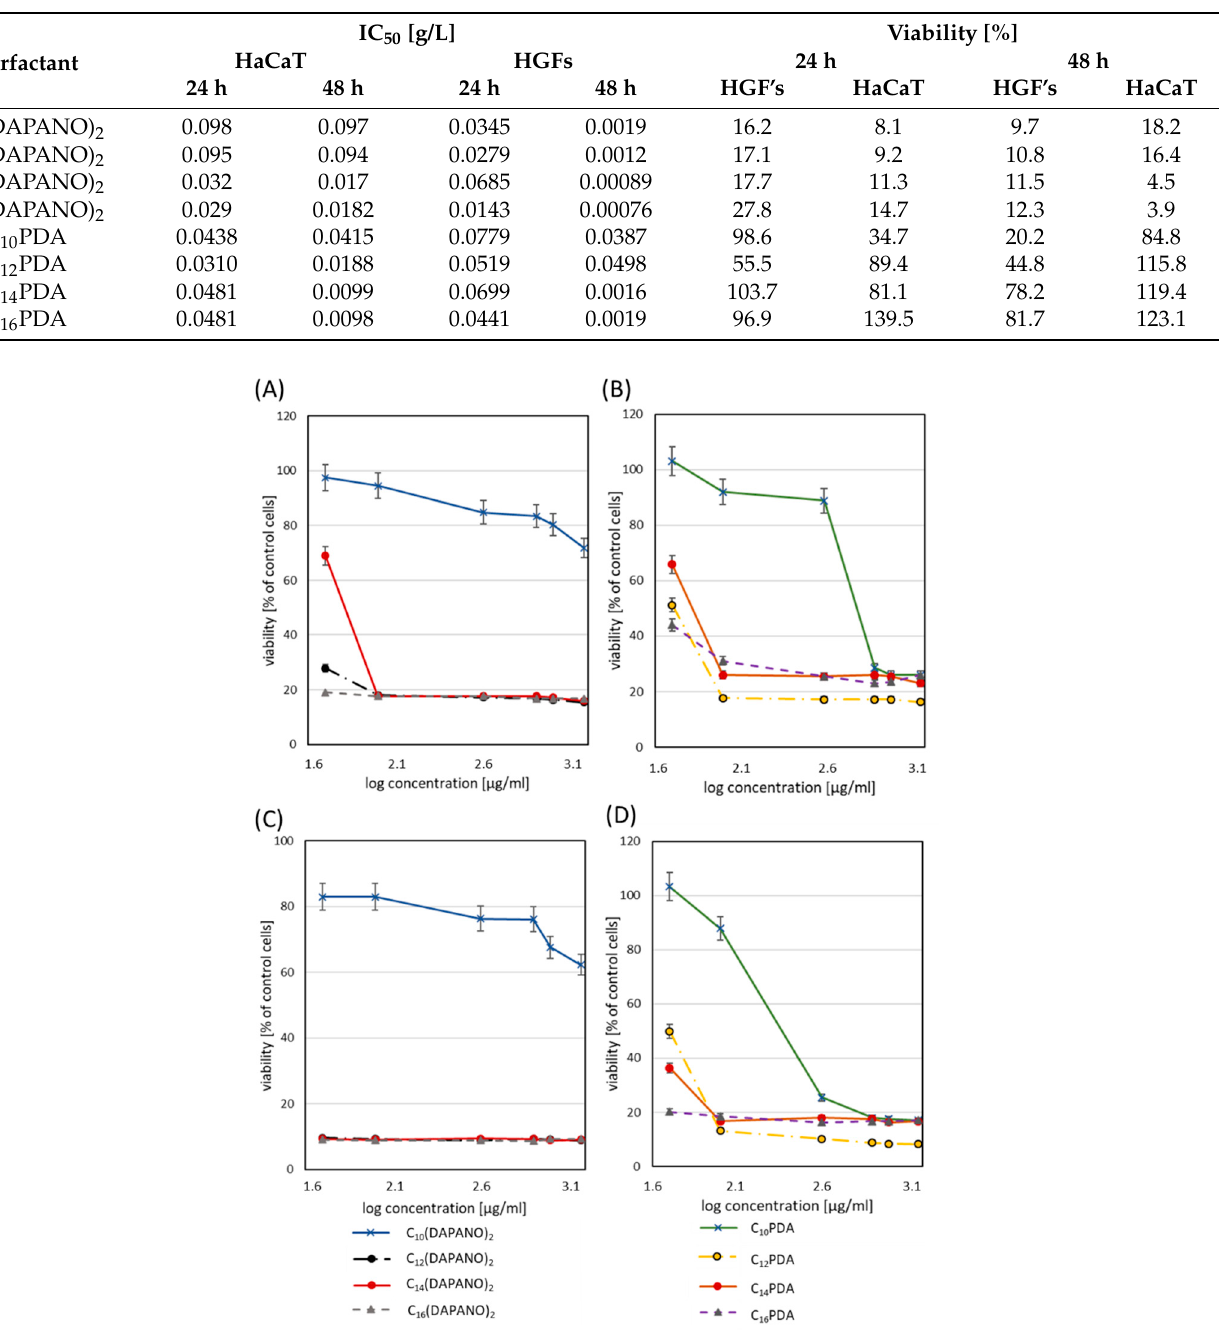
Figure 8. Evaluation of primary fibroblasts (HGFs) viability after 24 ( A , B ) and 48 h incubation ( C , D ) with C n (DAPANO) 2 and C n PDA surfactants in the range 50–2000 µ